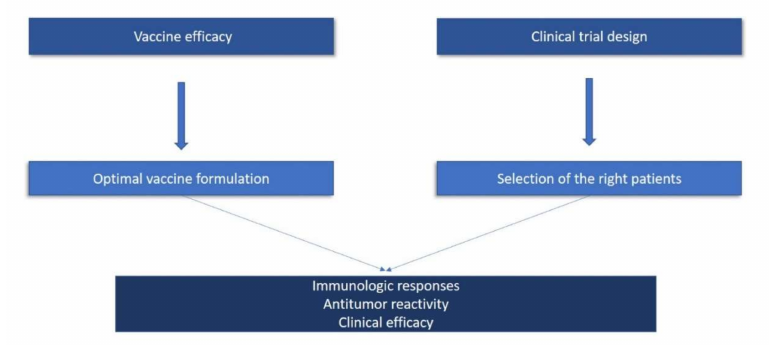
Figure 1. There are two major pillars that determine the potency of therapeutic cancer vaccines.